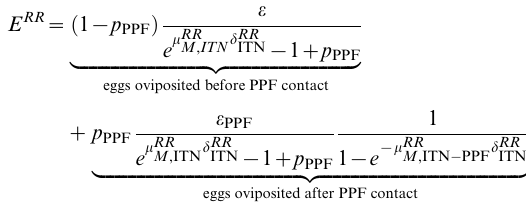
Figure S2 for more detail. The numbers and ratios of homozygous susceptible (SS) and resistant (RR) eggs that result from